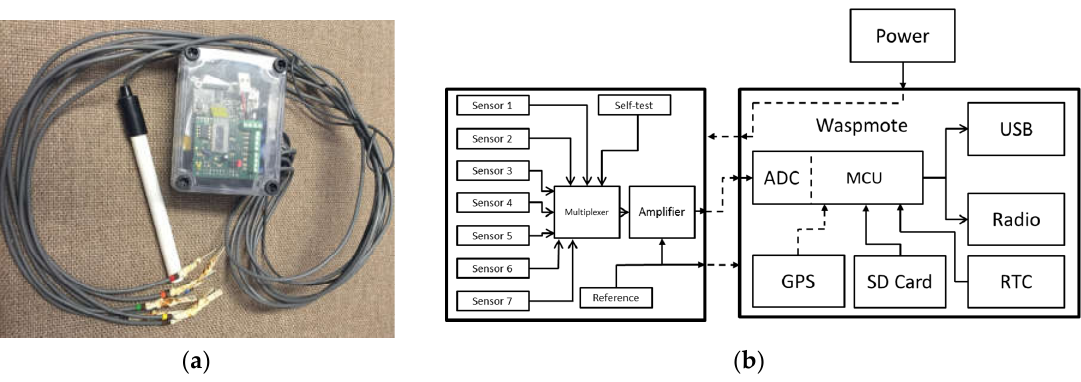
Figure 1. ( a ) Photograph of a logging system showing seven sensors, the reference electrode and box housing the logging electronics; ( b ) System diagram of the logging electronics.